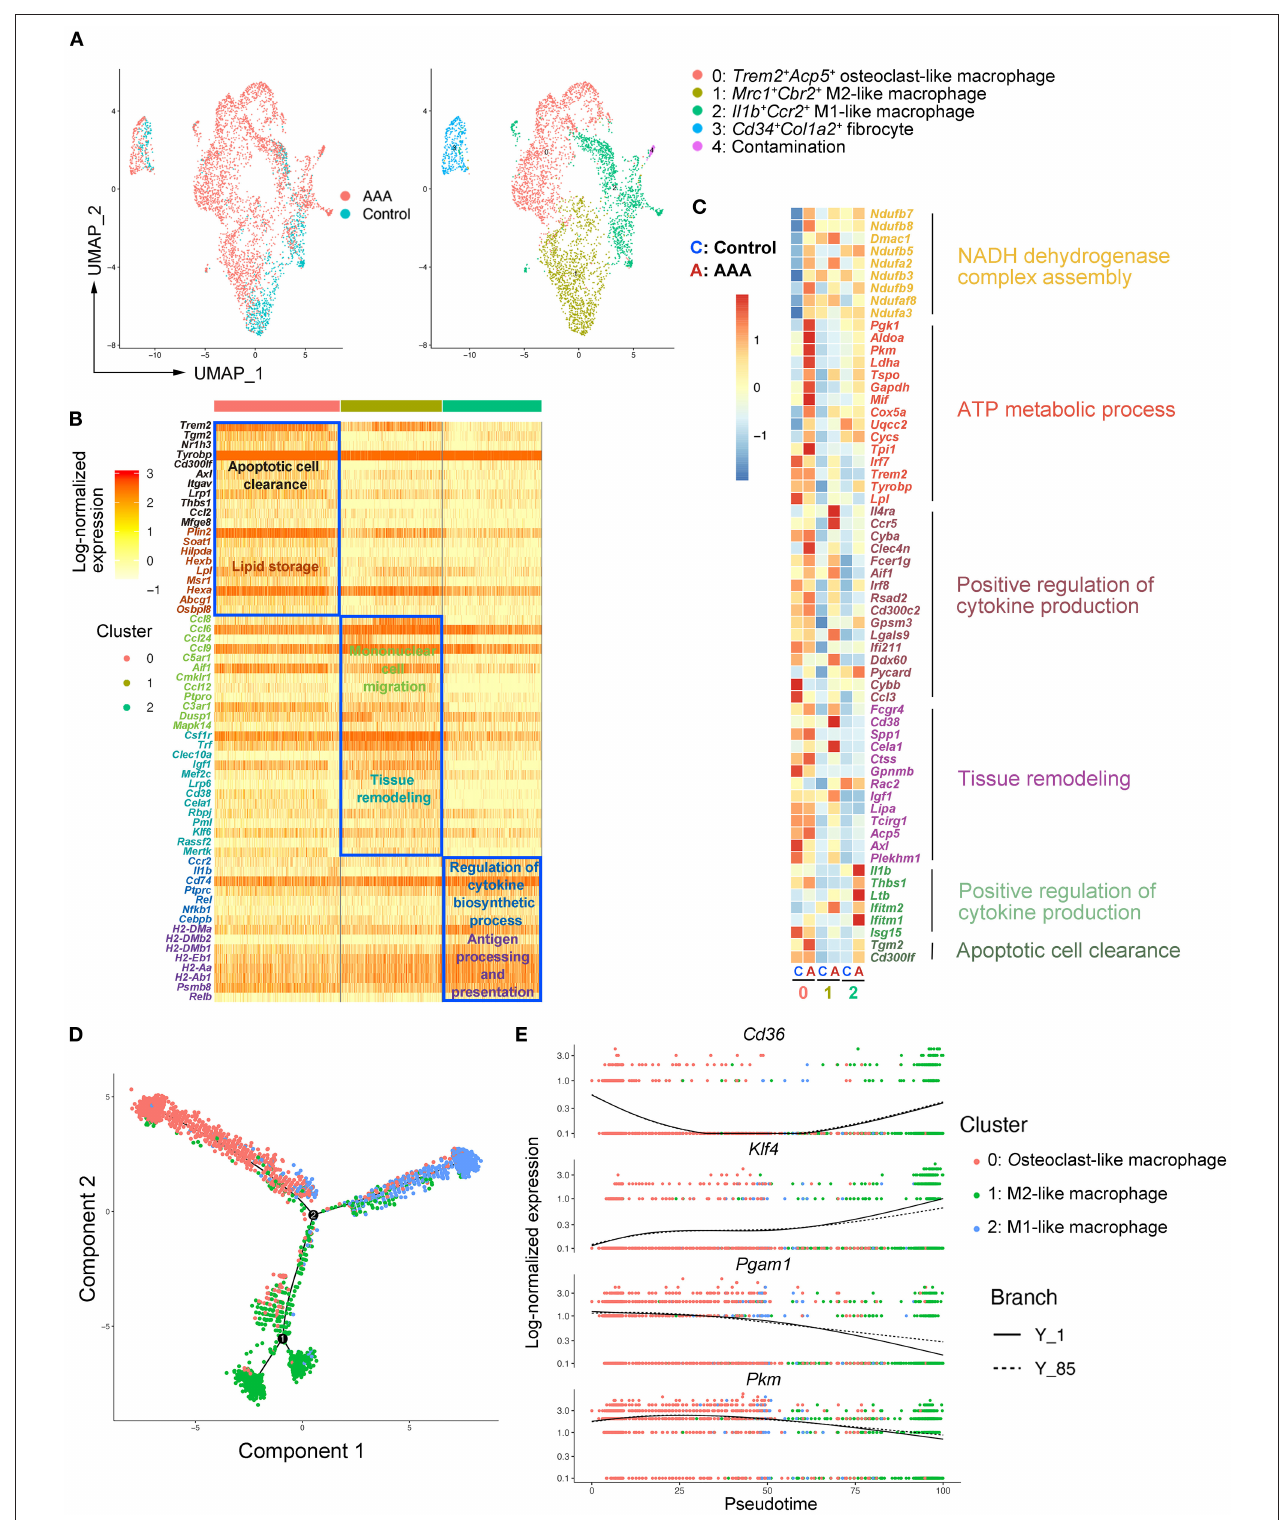
FIGURE 2 | Heterogeneity and re-polarization of macrophage subtypes in AAA. (A) Uniform manifold approximation and projection (UMAP) representation of the aligned gene expression data in macrophages separated from Figure 1B . (B) Heatmap of highly expressed genes (HEGs) from three subtypes of macrophages in (A)